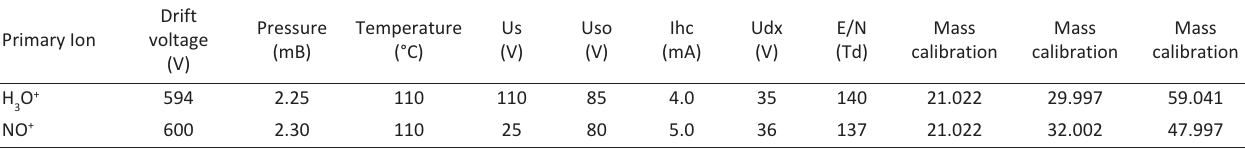
Table 1 ­ Instrumental condition throughout the